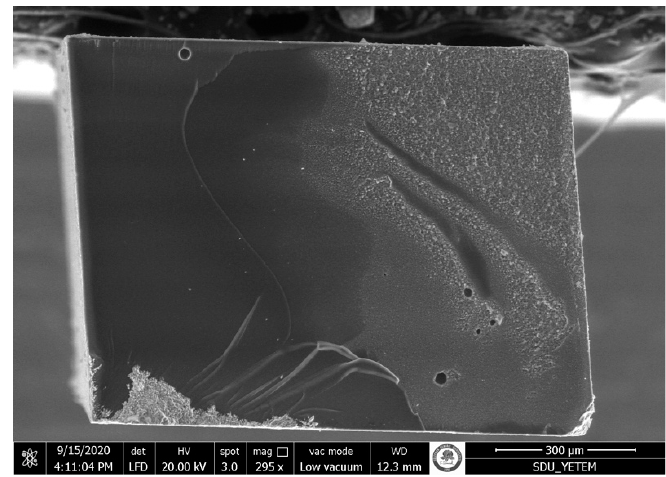
Universal group. An adhesive failure pattern was revealed.